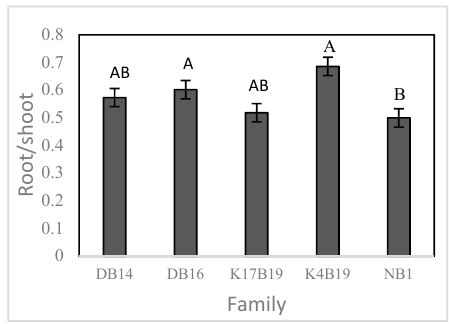
Figure 7. Variation of specific leaf area (SLA) of Senegalia senegal families. Different letters on bars mean significant differences among families at p < 0.05.